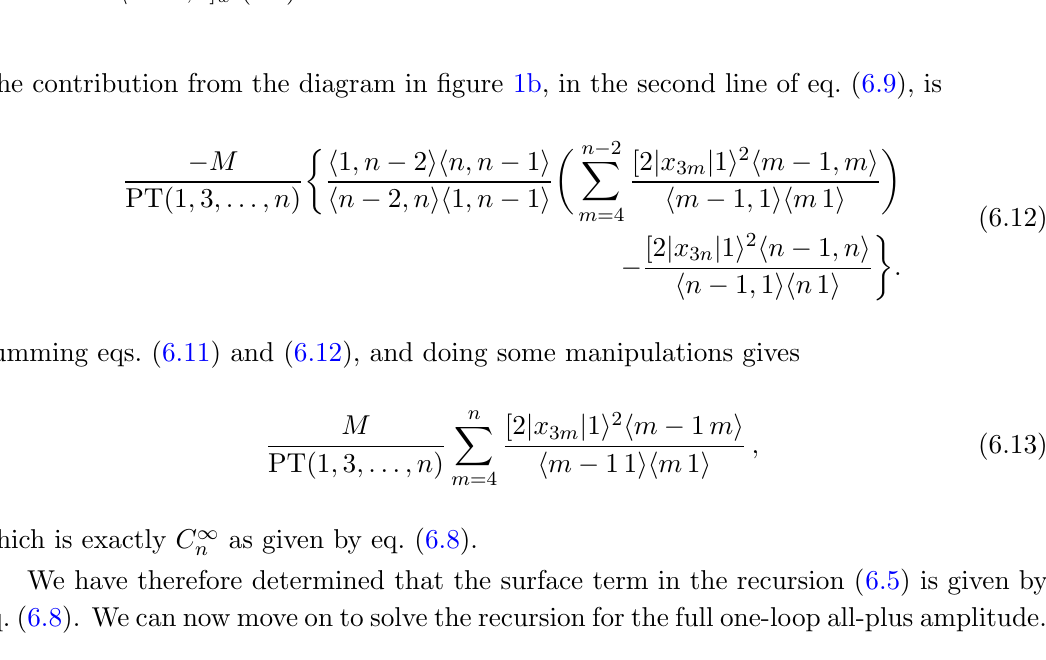
Figure 1. Diagrams contributing to the recursion (6.9) for the surface term C 1 BCFW shift h n (cid:0) 1 ; 1] w (6.7)